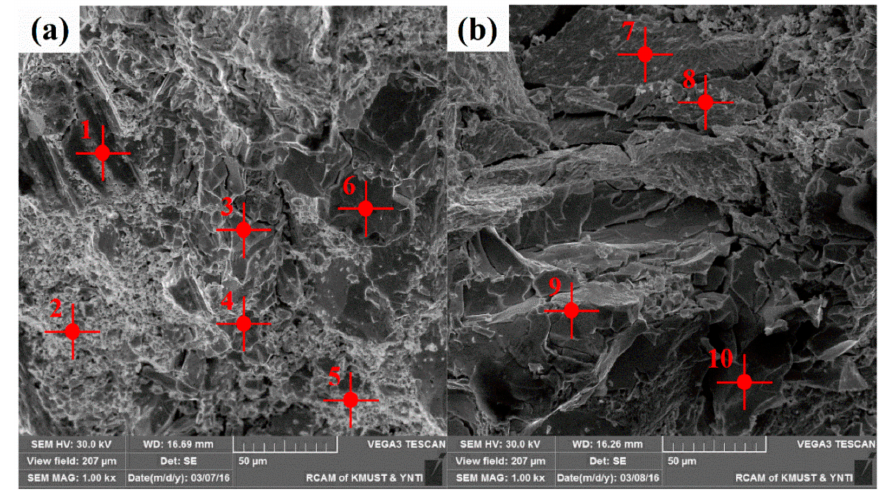
Figure 5. The compression fracture morphology of WC p /iron matrix composites with different particle shape: ( a ) spherical particle; ( b ) irregular